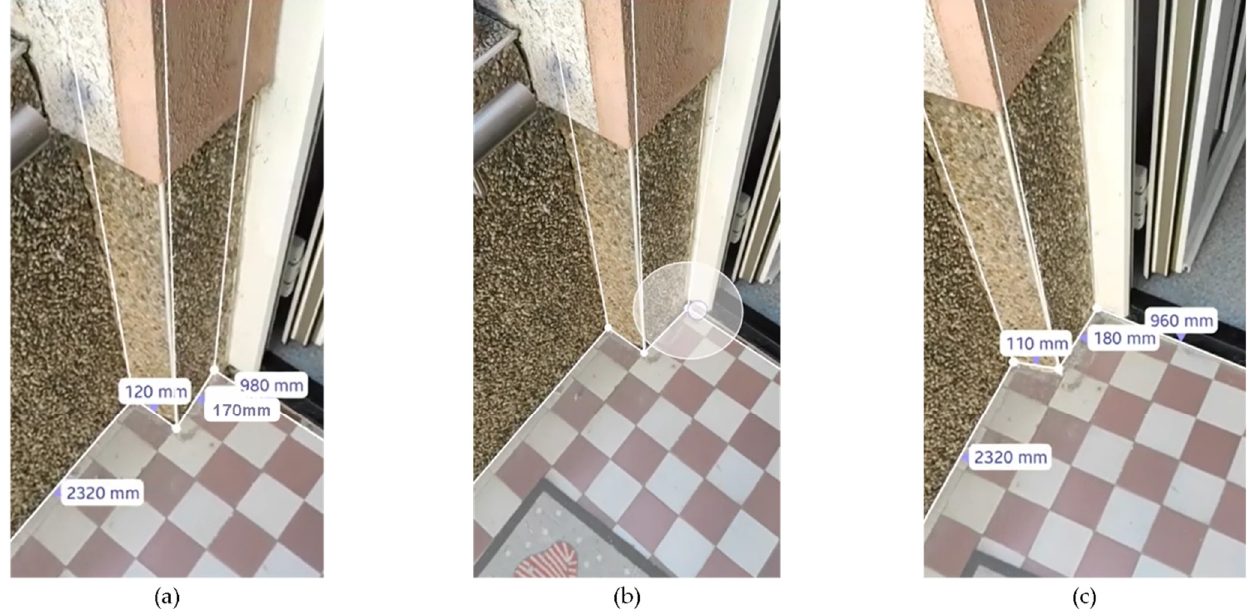
Figure 13. Capturing geometric nodes in 3D space: ( a ) 3D geometry node before snapping; ( b ) 3D geometry nodes in snapping; ( c ) 3D geometry node after snapping.